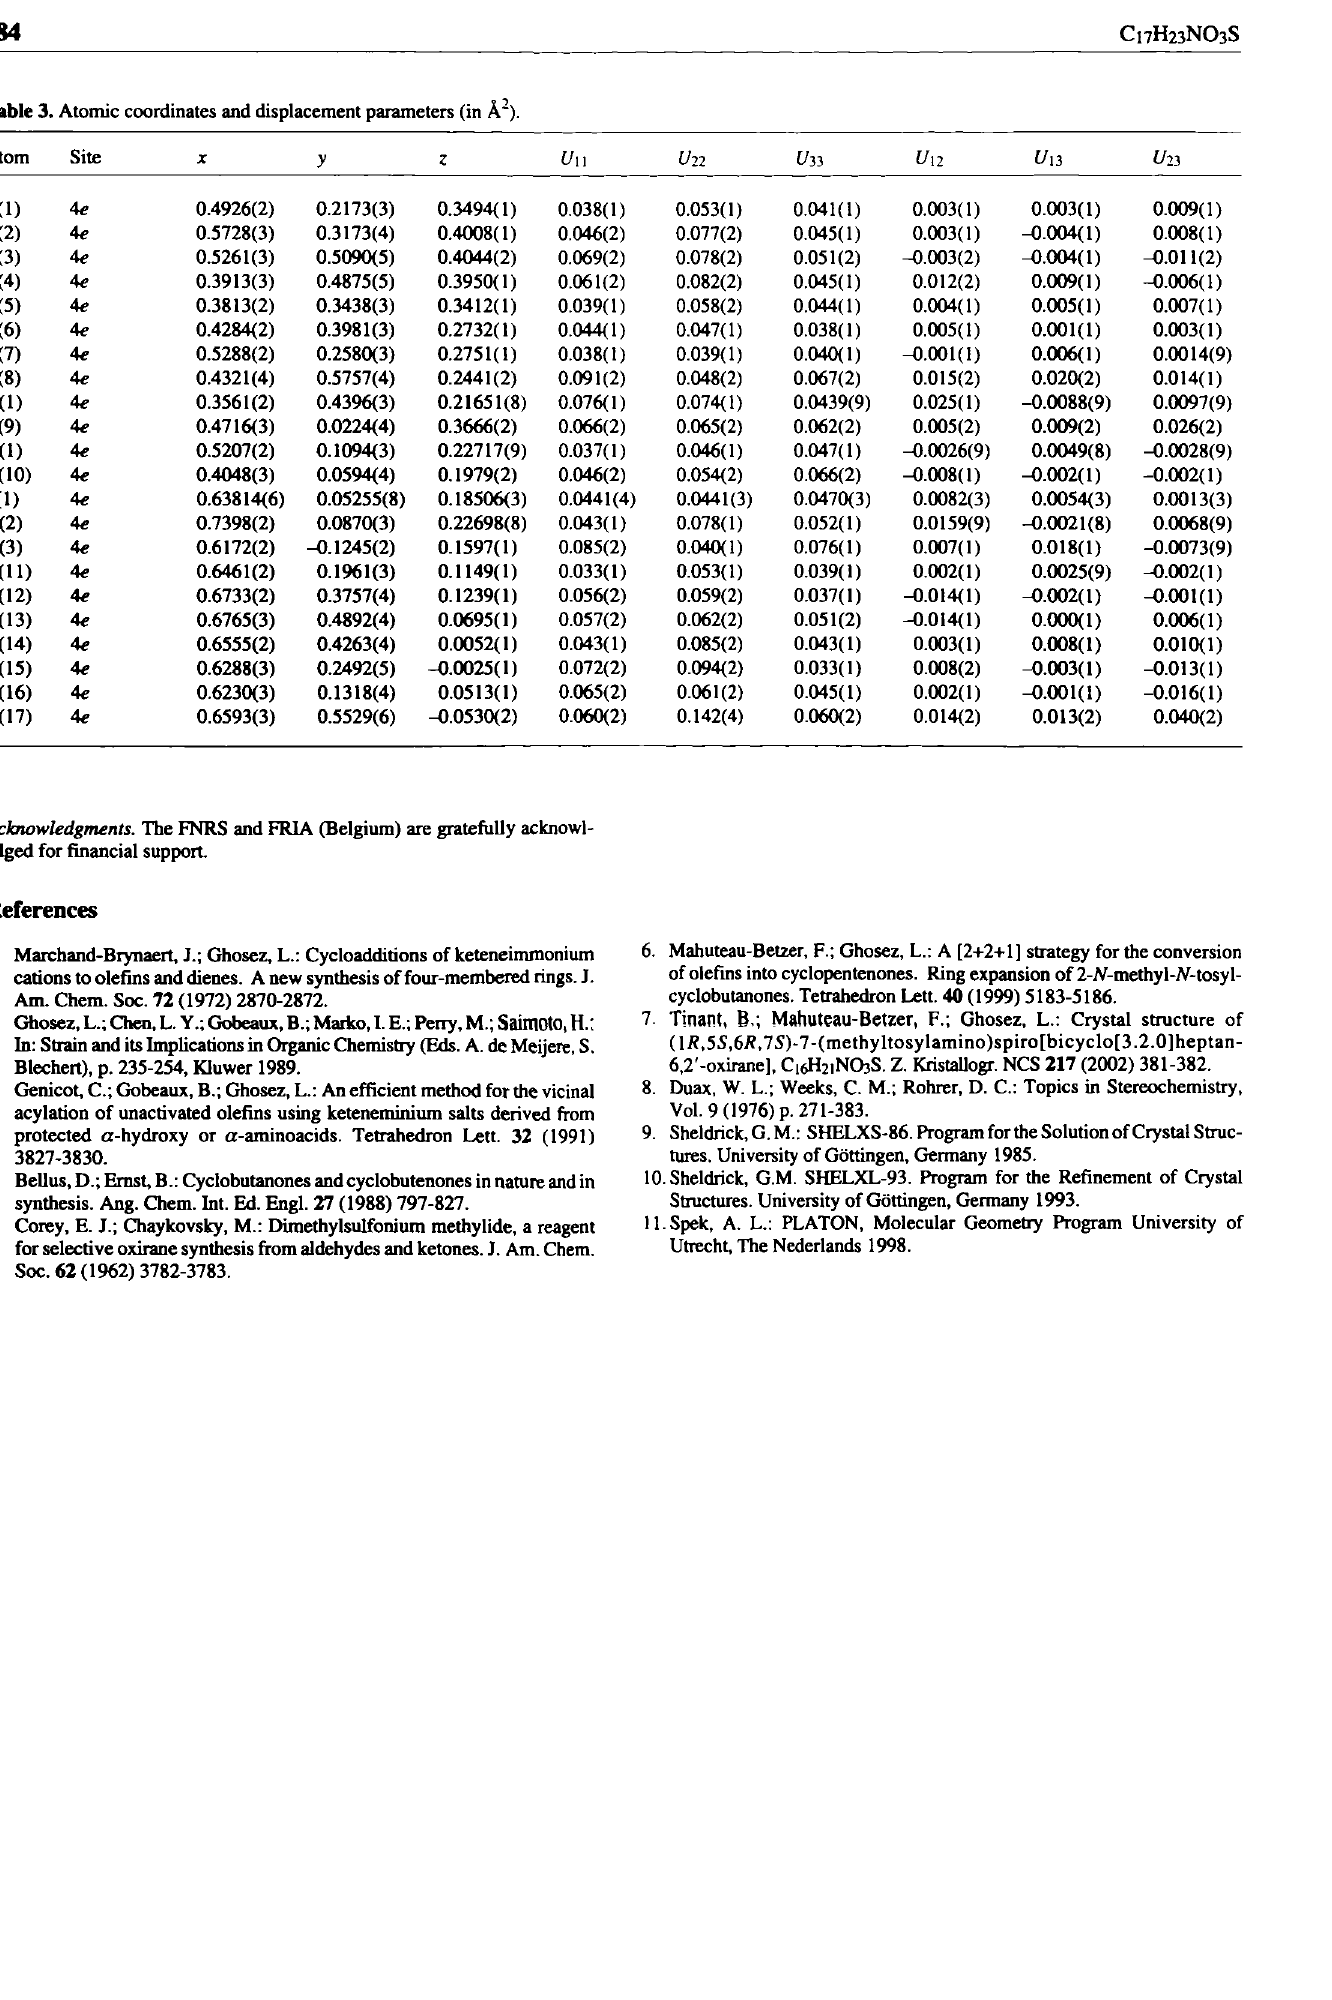
Table 3. Atomic coordinates and displacement parameters (in A 2